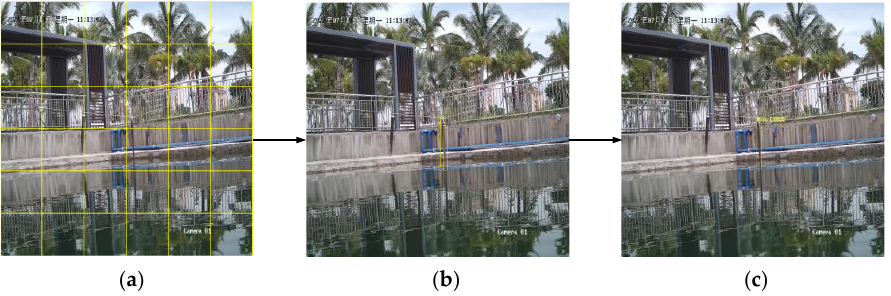
Figure 5. The detection process of original YOLOv3.( a )Original image,( b ) bounding boxes, ( c ) fi- nalresult.